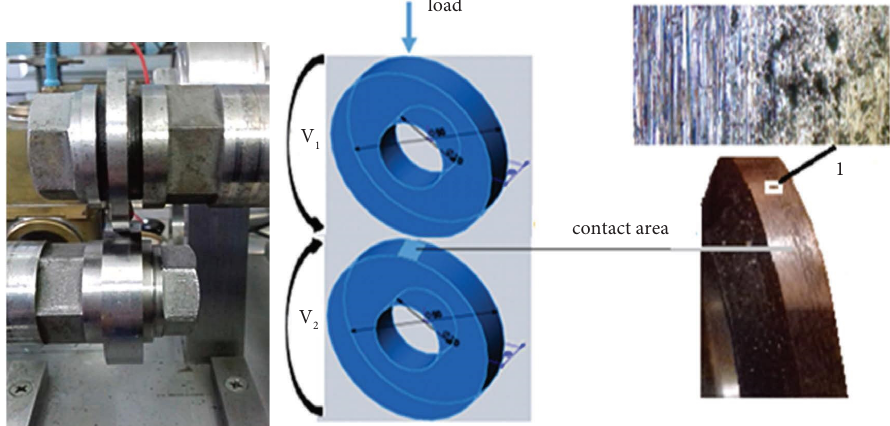
Figure 2: Te scheme of the loading unit of the test samples with rotation at speeds V 30ChGSA steel sample; 1: section of the contact surface of the sample for structural